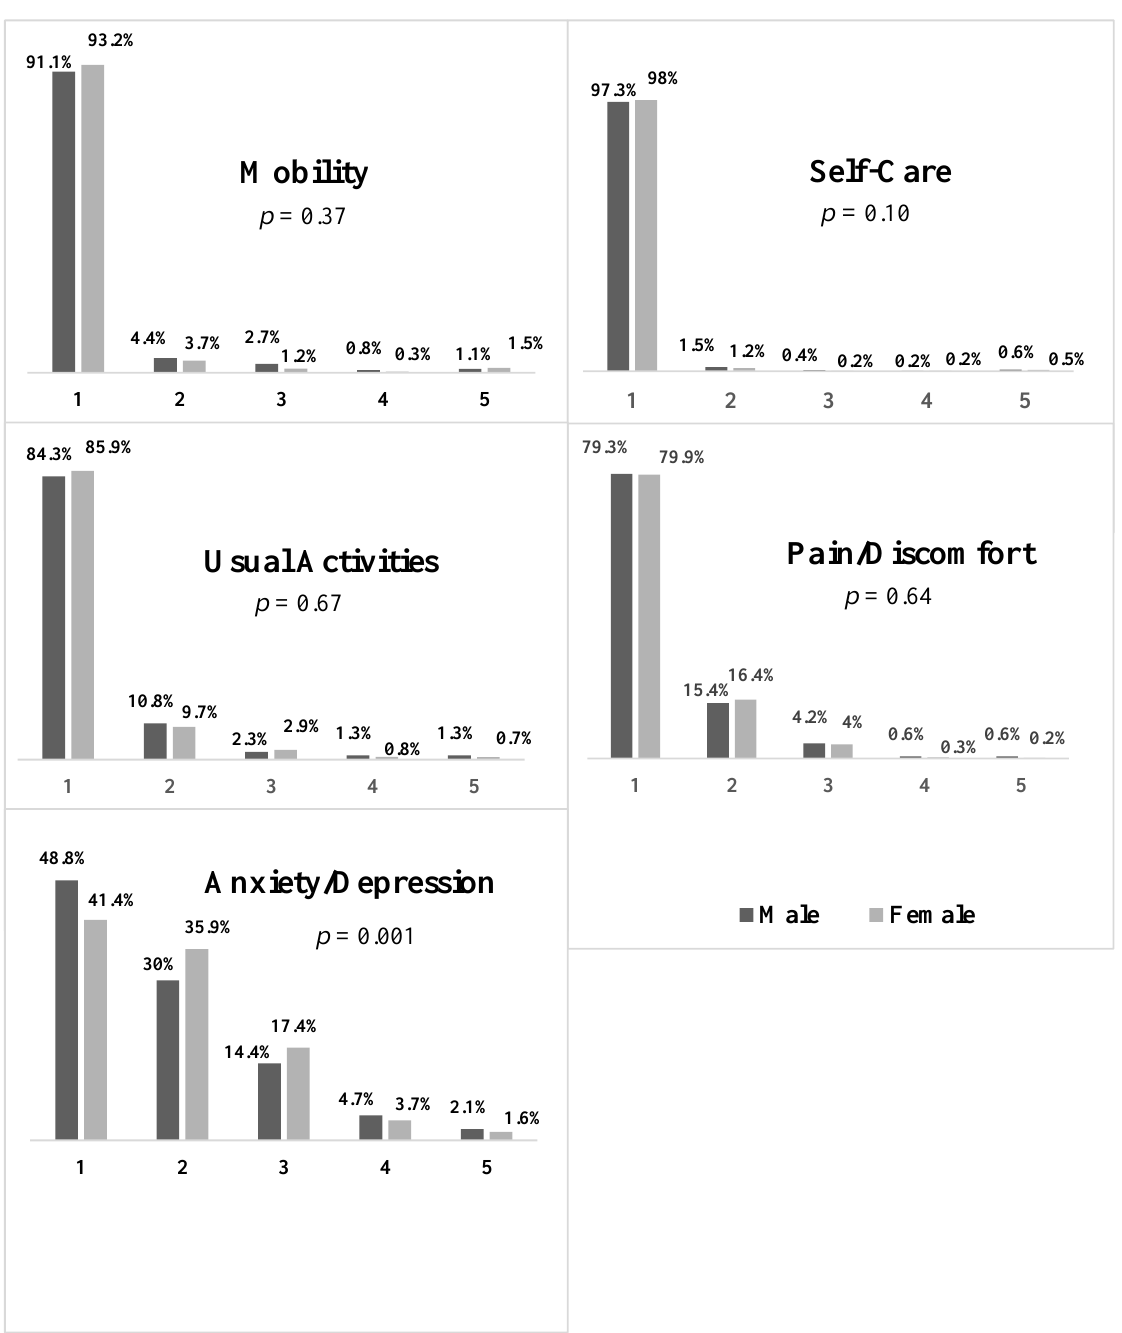
Figure 1. Profile of health-related quality of life among male and female students by levels of severity (1–5). It represents a respondent’s health status according to five dimensions: mobility, self-care, usual activities, pain/discomfort, and anxiety/depression. Within each dimension, there are five severity levels corresponding for mobility to no problem, slight problem, moderate problem, severe problem, and I am unable to walk about. For the self-care dimension, the levels of severity were no problem, slight problem, moderate problem, severe problem, and I am unable to wash or dress myself. Concerning usual activities, the levels corresponding to no problem, slight problem, moderate problem, severe problem, and I am unable to do my usual activities. For pain/discomfort, and anxiety/depression, the levels of severity corresponding to no problem, slight problem, moderate problem, severe problem, I have extreme pain or discomfort for pain/discomfort, and I am extremely anxious or depressed for anxiety/depression.